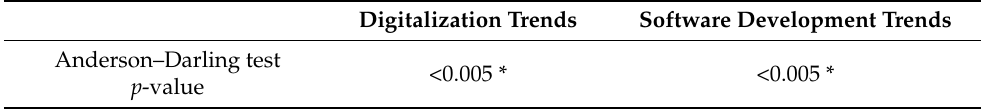
Figure 5. Box plot: comparison of the importance of the analyzed trends for manufacturing companies. *, ** denotes single observations. Table 6. Anderson–Darling normality test results—development